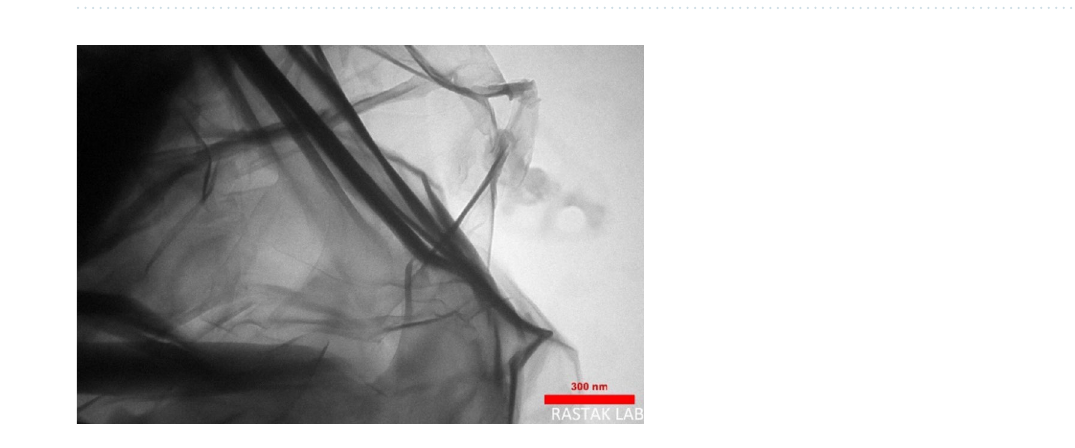
Figure 4. Elemental mapping of l-Arg-RGO.